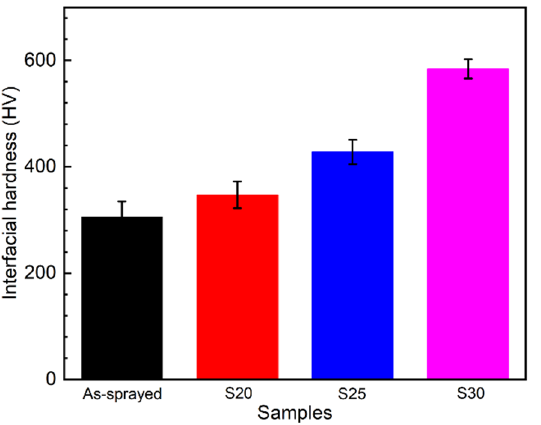
Figure 6. Interfacial hardness of the as-sprayed NiCrBSi, S20, S25, and S30 samples. S20, S25, and S30 indicate the as-sprayed NiCrBSi coatings remelted at 20 kW, 25 kW, and 30